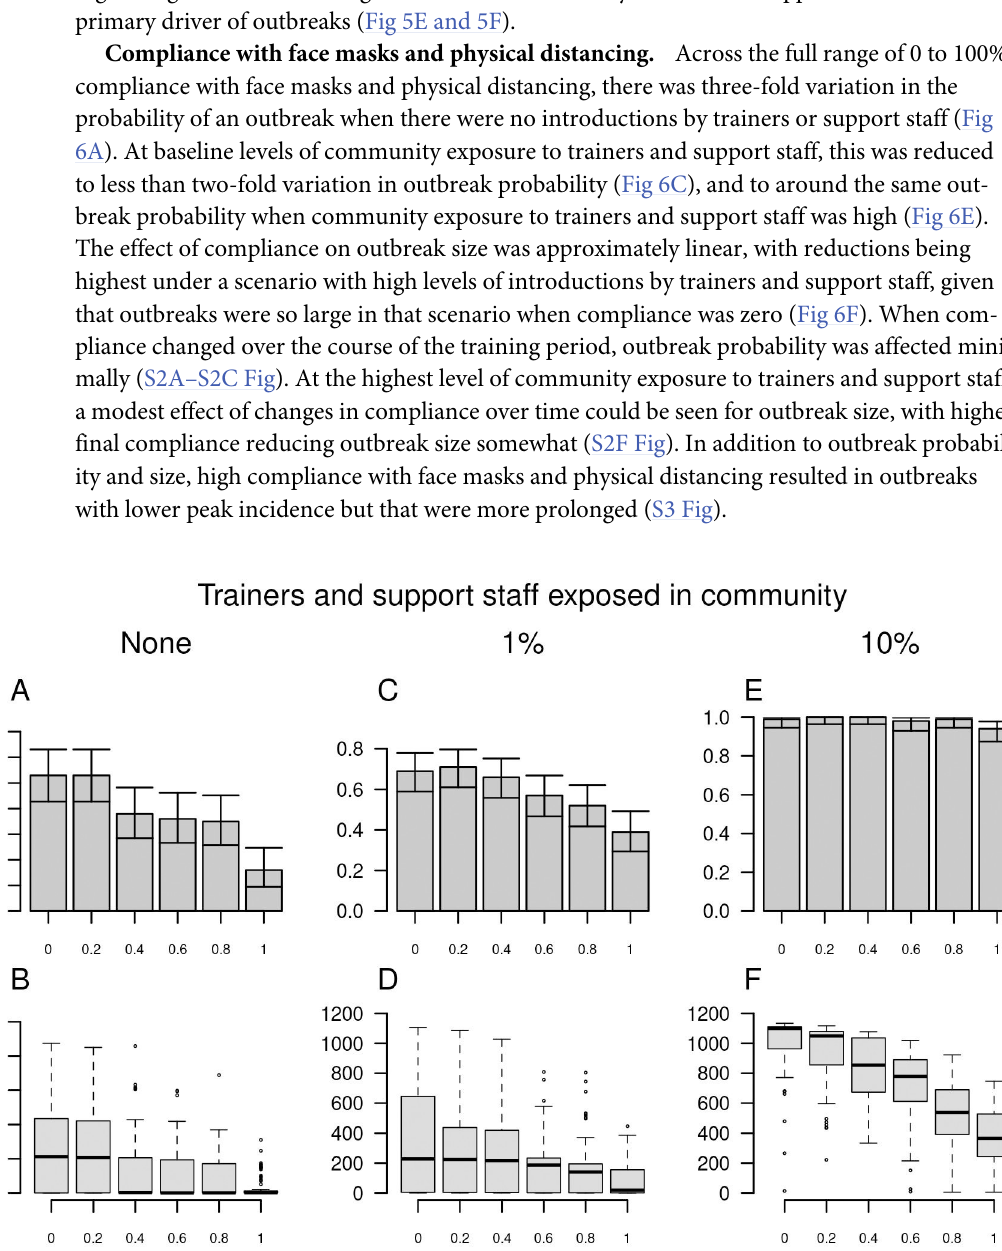
PLOS Computational Biology | https://doi.org/10.1371/journal.pcbi.1010489 October 7,